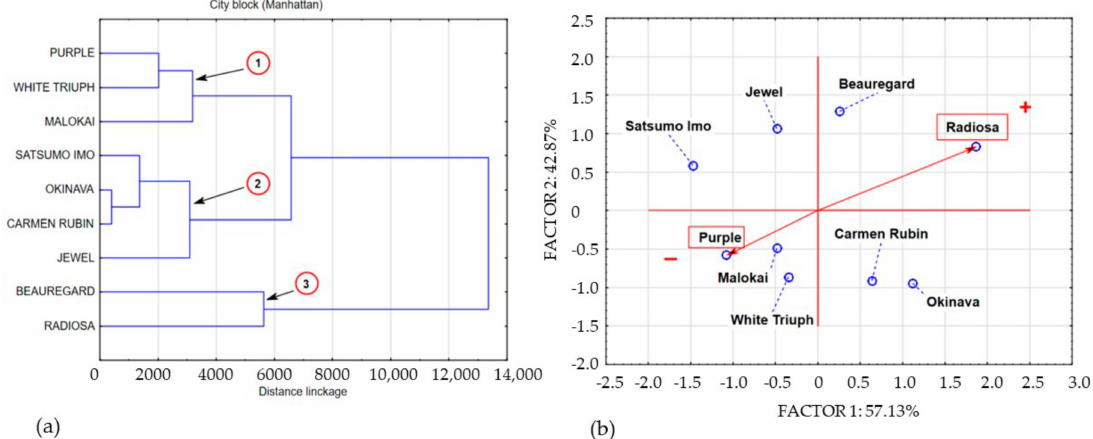
Figure 4. Dendrogram and bio-plot (PCA) of average concentrations of polyphenols in sweet potato leaves collected in BBCH phase 89. ( a ) 1,2,3,4 clusters. ( b ) + variety with the highest concentration polyphenolics compounds, − variety with the lowest concentration polyphenolics